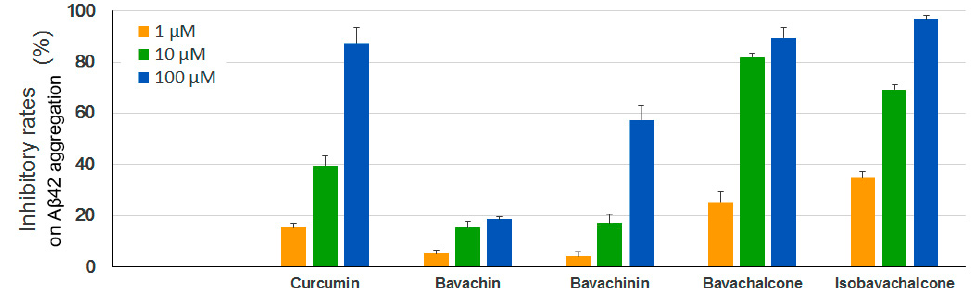
Figure 5. Inhibitory effects of PF compounds on A β 42 aggregation. Synthetic A β 42 peptide was diluted in PBS to 50 µM, incubated with different concentrations of PF compounds at 37 °C for 24 h, mixed with ThT solutions and measured at 440/490 nm (excitation/emission). Curcumin was used as a positive control. Data are expressed as mean ± SEM.